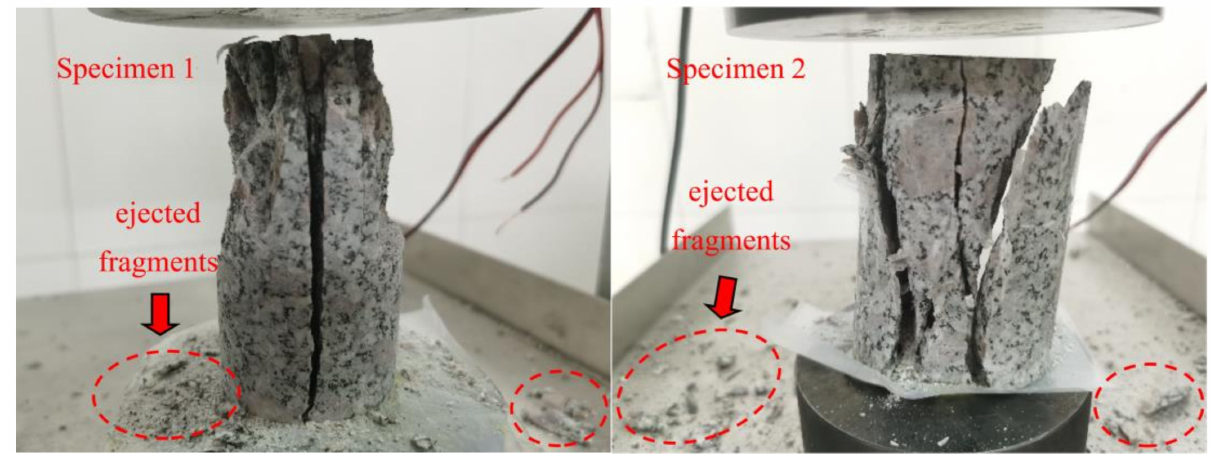
Figure 6. The specimens after